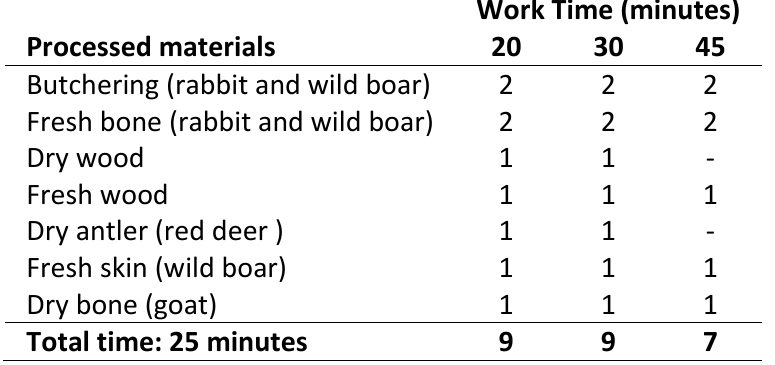
Table 2. Reference collection. Materials worked with the experimental quartzite flakes.